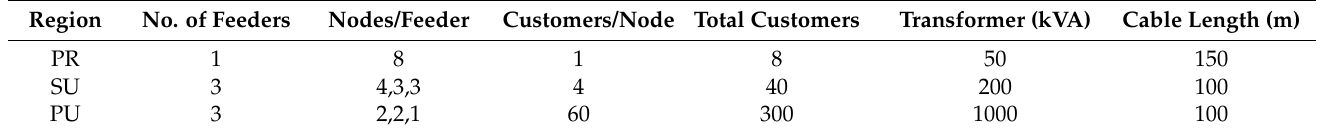
Table 1. LV test networks’ characteristics and grid components specifications.